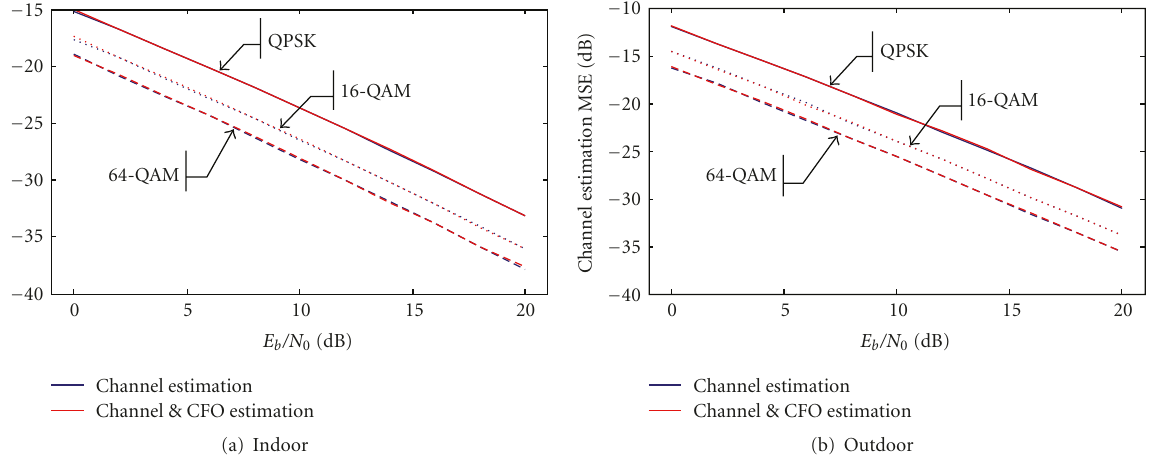
Figure 6: Joint channel and CFO estimation MSE.